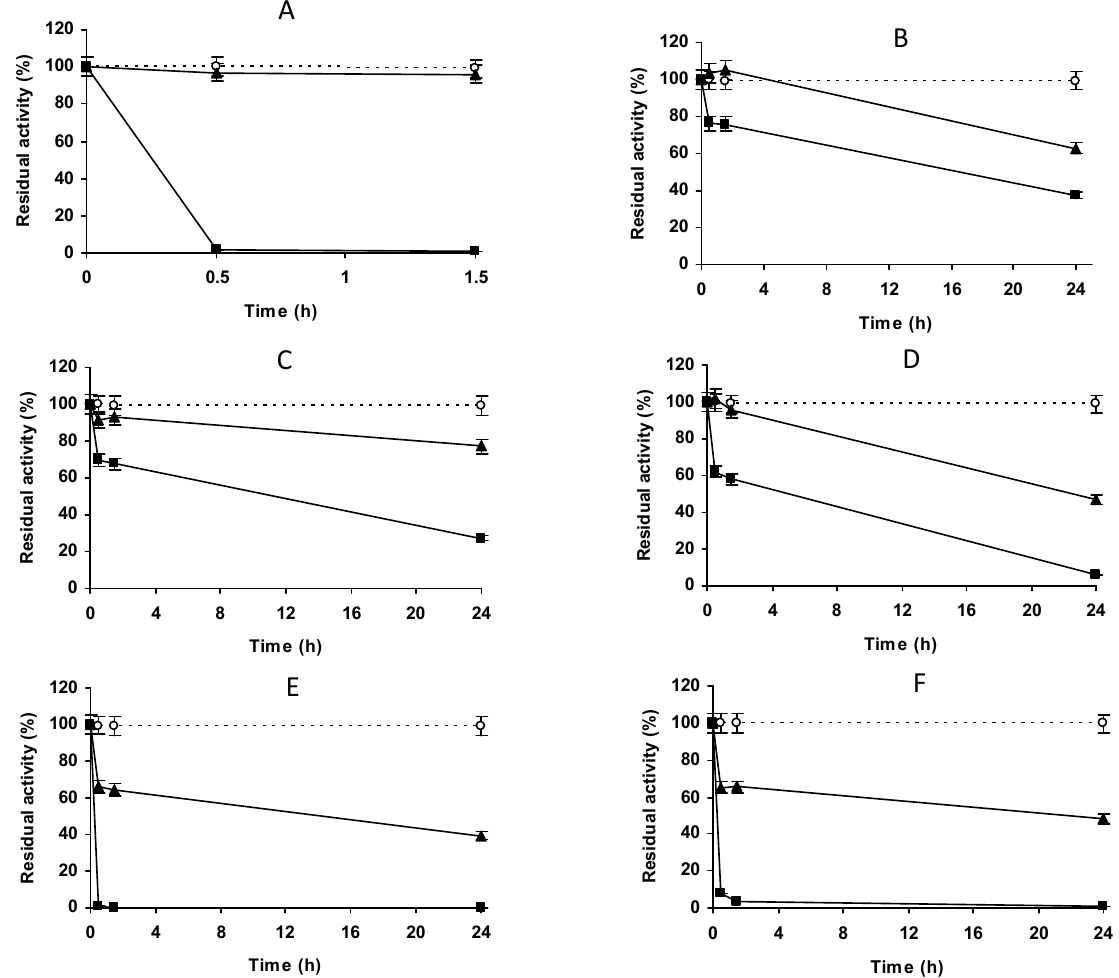
Figure 6. Immobilization courses of PGA (2.5 mg/g) on glyoxyl agarose ( A ) and on vinyl sulfone agarose at different concentrations of sodium sulfate at pH 8.0, 25 °C in 50 mM sodium phosphate at pH 8.0, 25 °C. ( B ) 100 mM; ( C ) 250 mM; ( D ) 500 mM; ( E ) 1 M; ( F ) 2 M. Empty circles with dashed line: reference suspension. Full triangles with solid line: suspension. Full squares with solid line: supernatant. Other specifications are described in Methods.